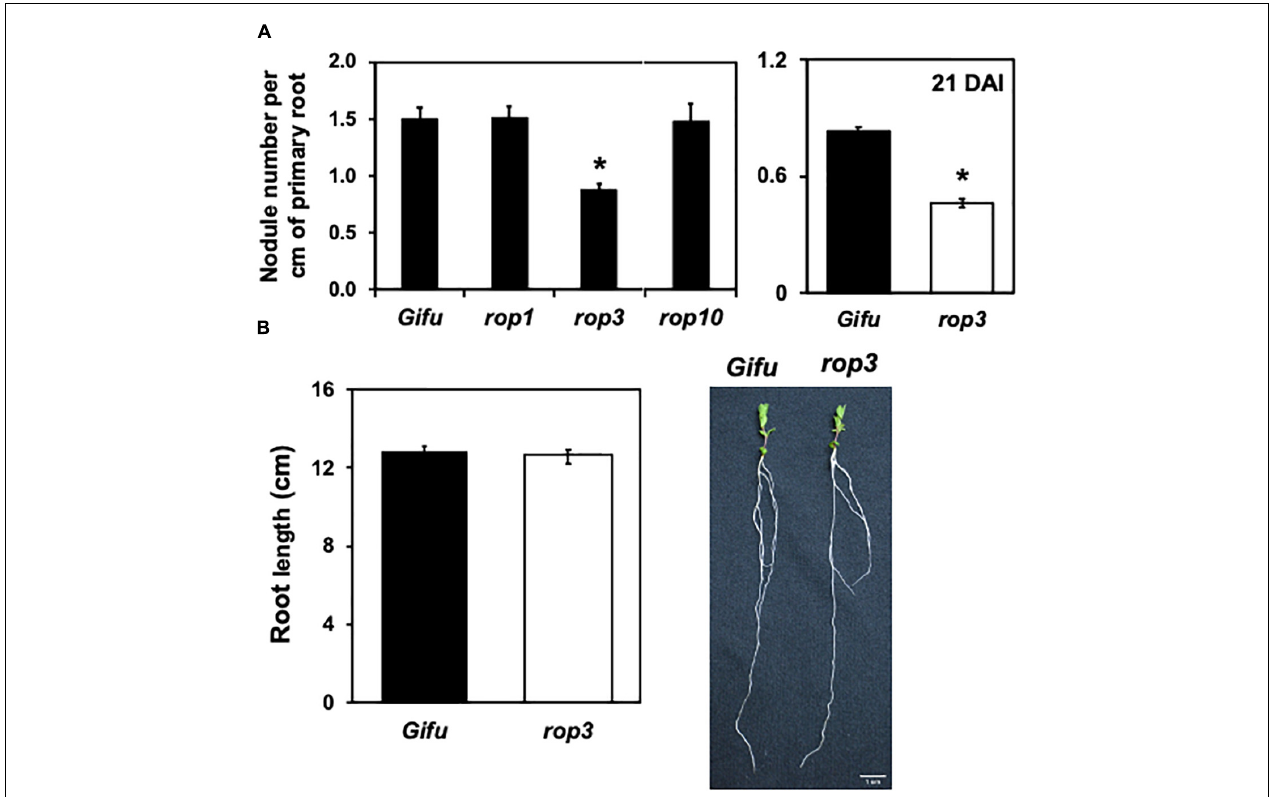
FIGURE 1 | rop3 mutant presents defects in the L. japonicus-M. loti symbiosis. Lotus japonicus Gifu wild-type and the indicated mutant lines were inoculated with M. loti and (A) number of nodules were quantified at 7 DAI (left) and at 21 DAI (right). (B) Primary root length of L. japonicus plants grown under optimal conditions were measured, and pictures of representative Gifu wild-type and rop3 plants are shown. Bars represent mean values ( ± SD) of 3 independent experiments ( n > 15). The asterisk indicates statistical significance between the indicated mutant and Gifu wild-type according to one way ANOVA test and a post hoc analysis ( p < 0.05).